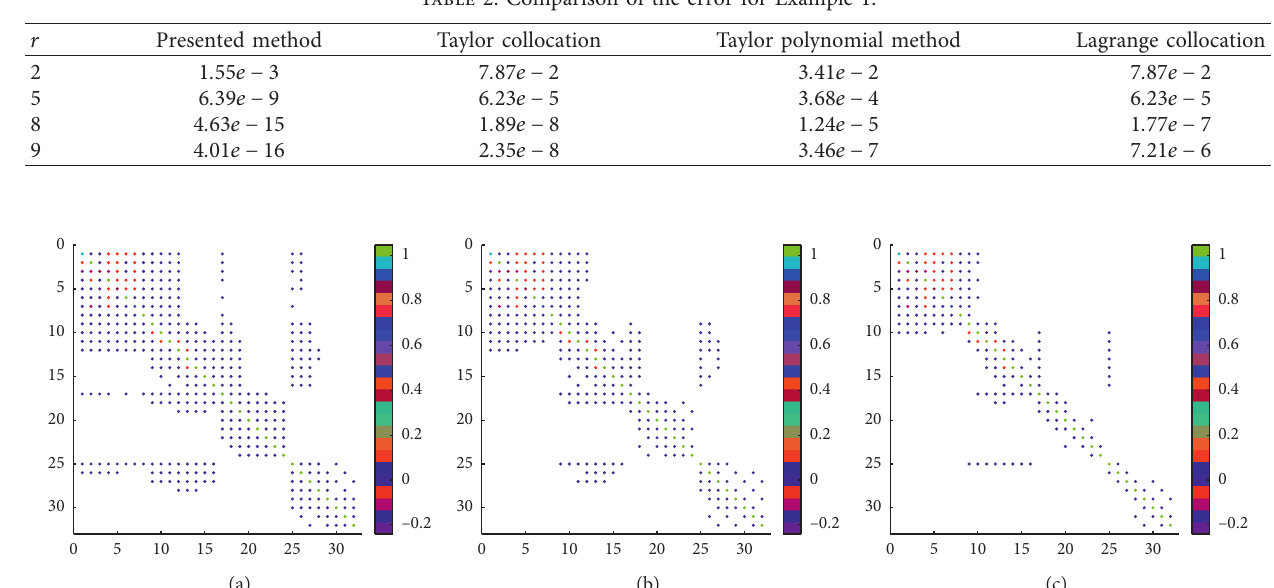
Figure 4: The effect of thresholding with threshold ε � 10 − 5 (left), ε � 10 − 4 (middle), and ε � 10 − 3 (right) on the coefficient matrix for Example